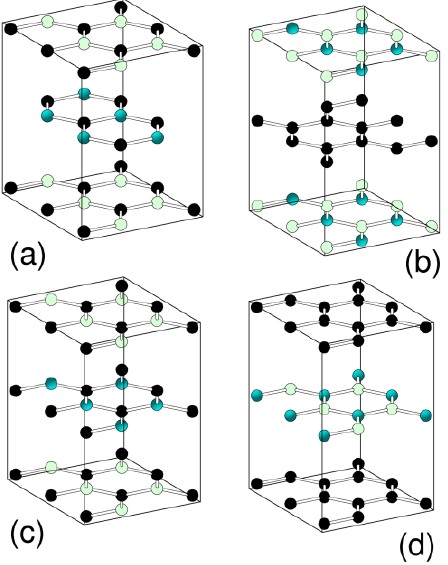
Figure 3. Various graphitic structures considered for hexagonal BC ( c ) follow stacking as for graphite, structures ( b ) and ( d ) as for h-BN. The shading of spheres is white B, black C and grey N.